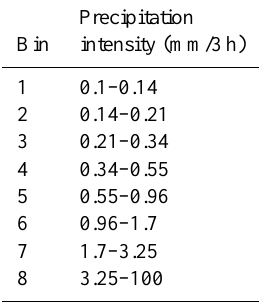
Table 3. Binning of precipitation intensity into eight